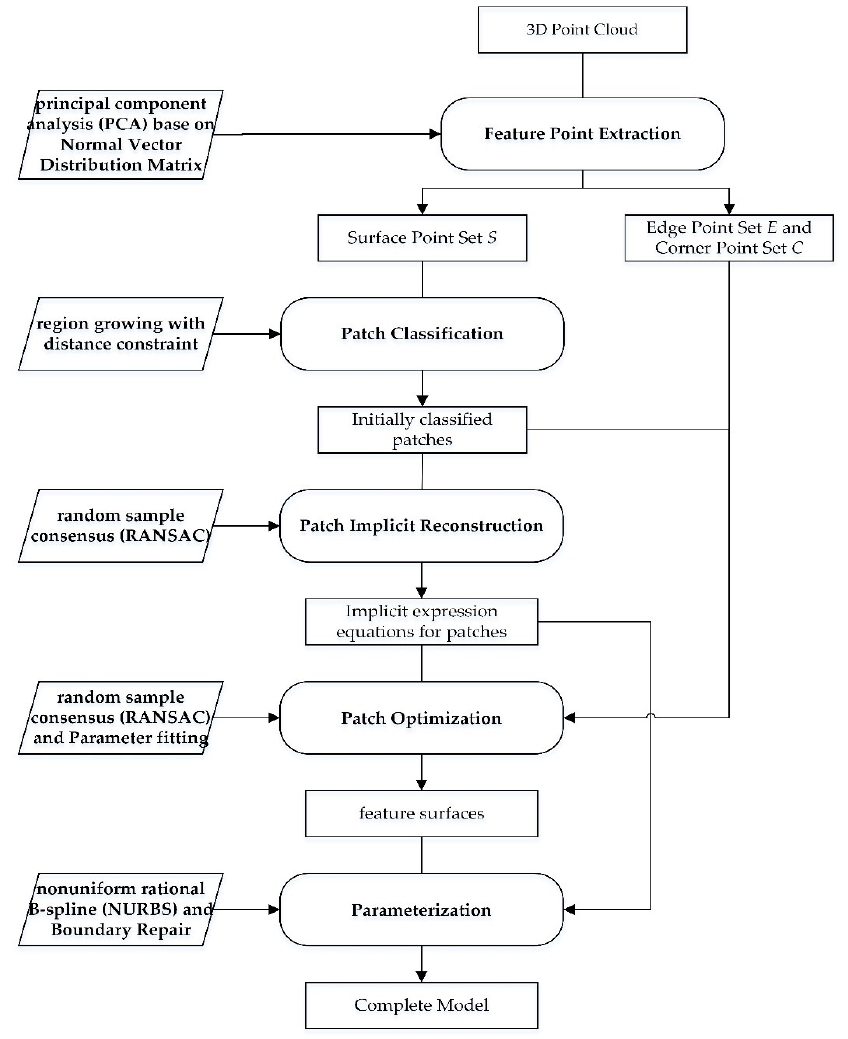
Figure 1. Flowchart of the feature surface extraction method.